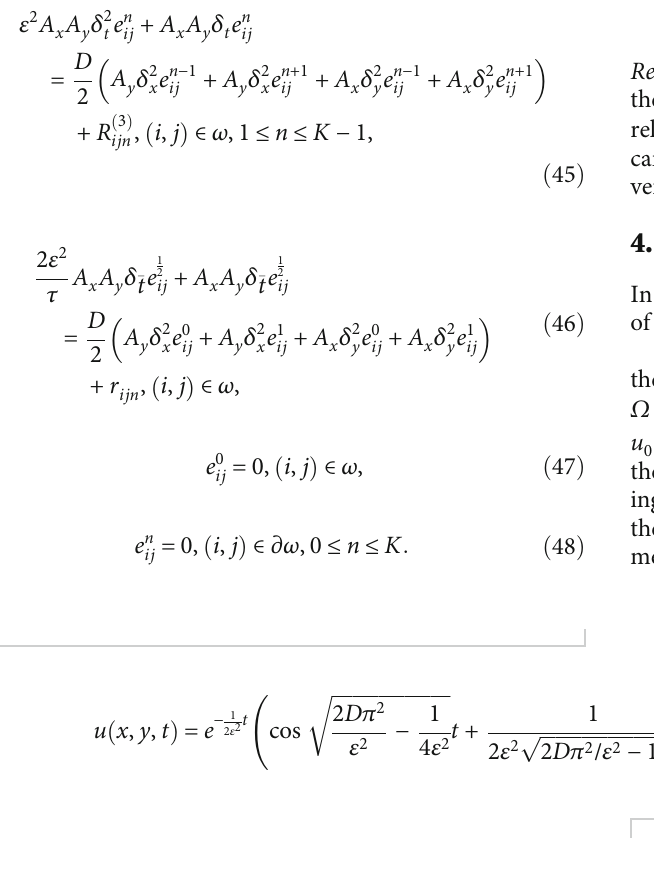
ffiffiffiffiffiffiffiffiffiffiffiffiffiffiffiffiffiffiffiffiffiffiffi ffiffiffiffiffiffiffiffiffiffiffiffiffiffiffiffiffiffiffiffiffiffiffiffiffiffiffiffiffiffiffi p 2 D π 2 / ε 2 − 1/4 ε 2 2 ε 2